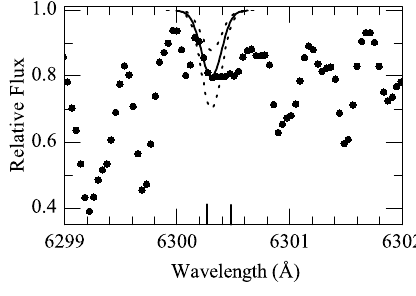
Fig. 6. The observed spectrum of HD 209621 around the forbidden oxygen line at 6300.304 ˚A. The three synthetic profiles are given for the oxygen abundance log ϵ (O) = 7 . 54 ± 0 . 3. Positions of the close CN lines are marked by vertical